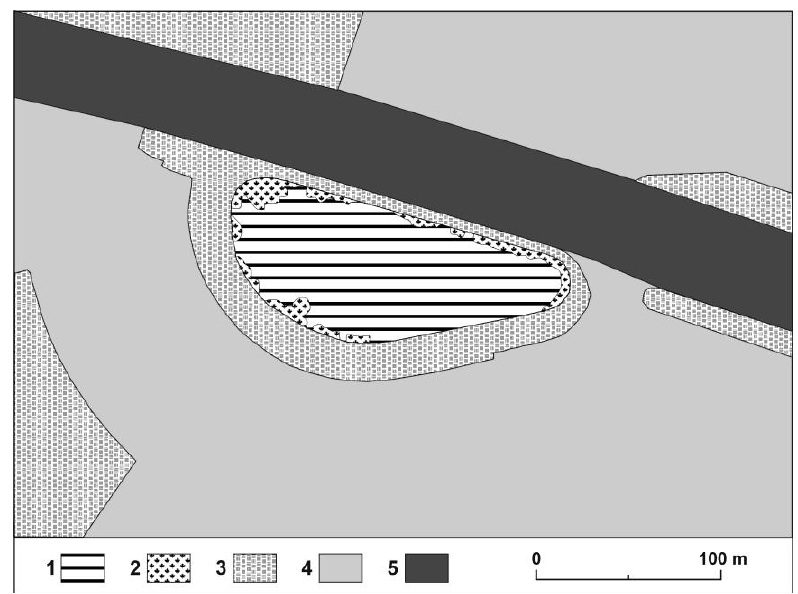
Fig. 1. Neighbourhood of the investigated water